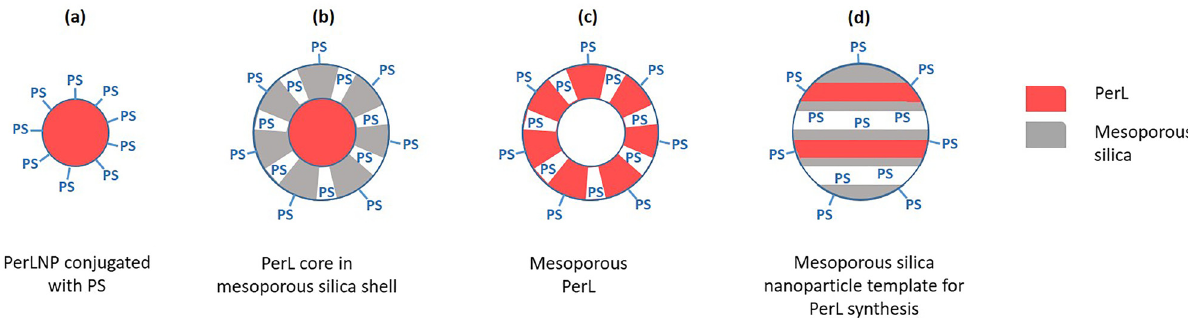
Figure 7: Variety of PS and PerLNP associations in reported examples of PerL-mediated